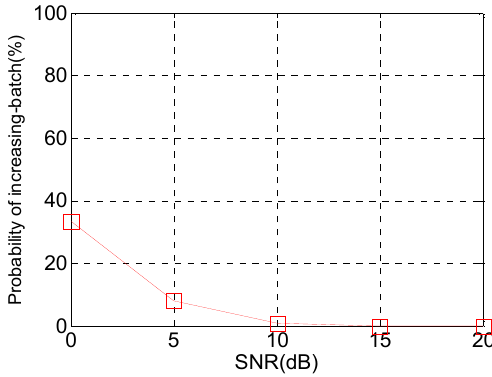
Figure 11. Probability of increasing-batch in different SNRs.